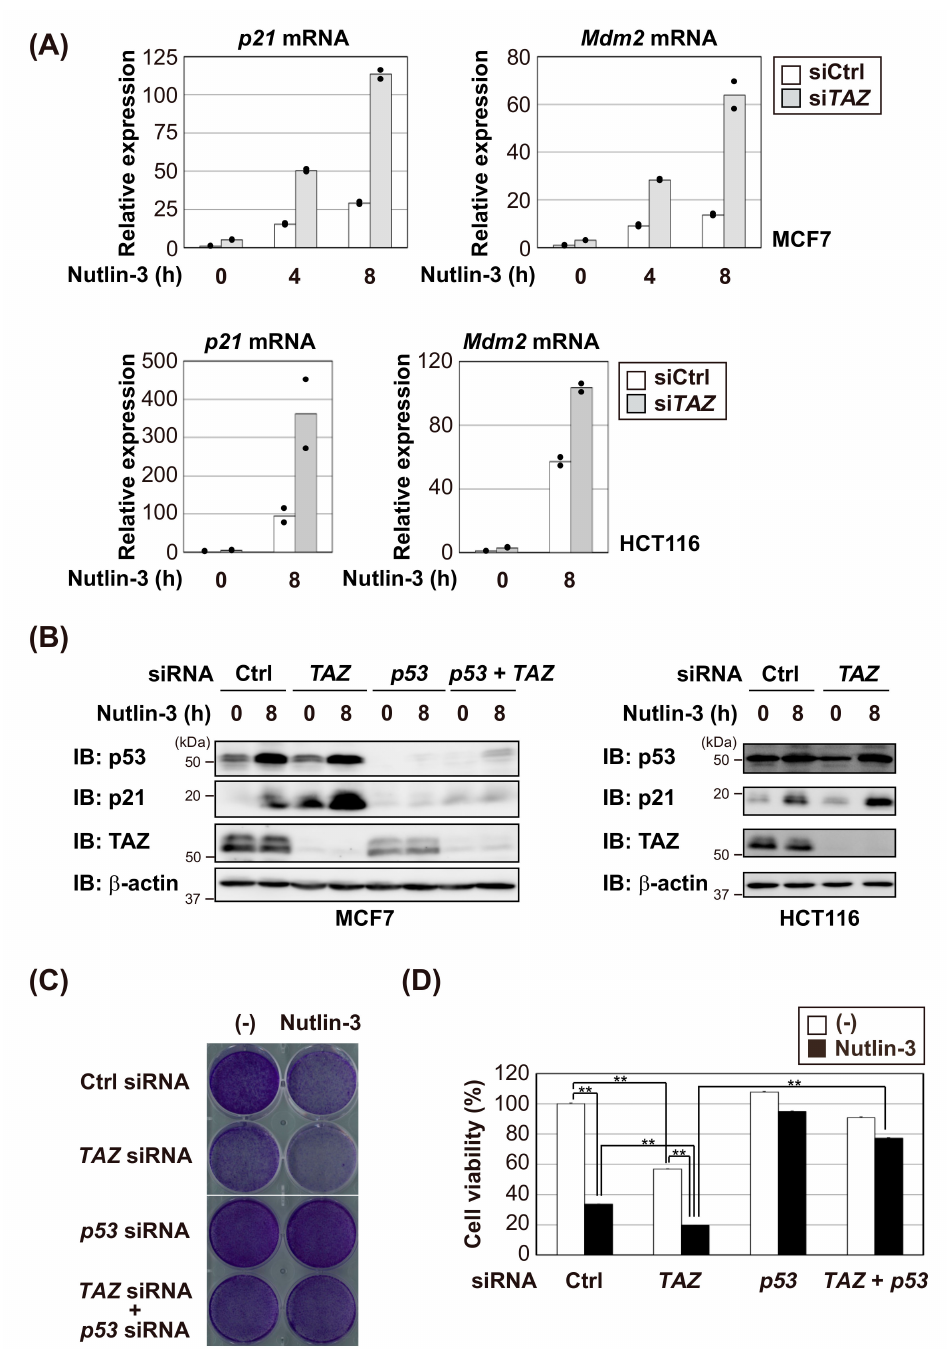
Figure 2. TAZ knockdown enhances the transcriptional activity of p53. ( A , B ) MCF7 cells and HCT116 cells were transfected with the indicated siRNAs and treated with 10 µ M Nutlin-3 for 8 h. The expression levels of p53 target genes were analyzed by RT-qPCR (duplicate determination) (A) or immunoblotting ( B ). ( C , D ) TAZ knockdown reduced cell viability after the Nutlin-3 treatment. MCF7 cells were transfected with the indicated siRNAs, and then treated with 10 µ M Nutlin-3. After 48 h, cells were stained with crystal violet ( C ). The quantification of data is represented ( D ). Significant di ff erences are indicated as ** p <